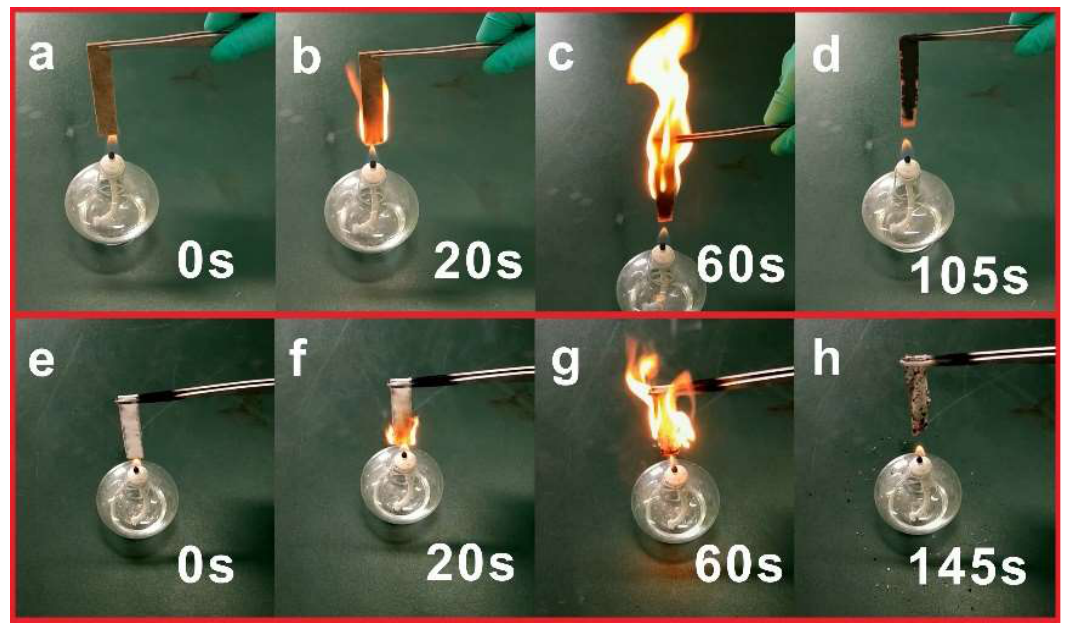
Figure 8. Combustion process of ( a – d ) MDFs; ( e – h ) MDFs coated with PDMS @FDTS-Mg/Al LDH.